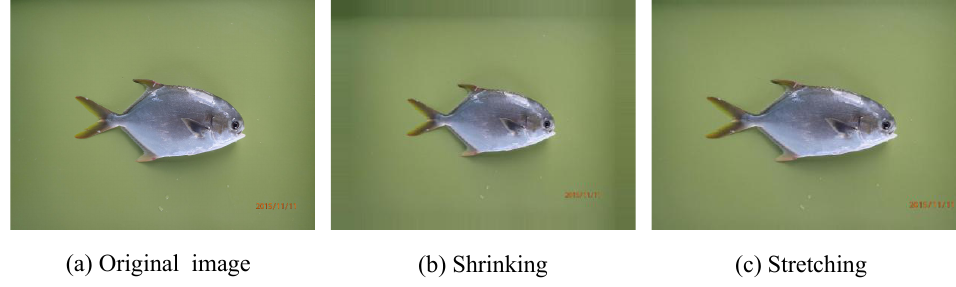
Fig. 6. Effect of the scaling transformation. Figure 7. Data augmentation by scaling